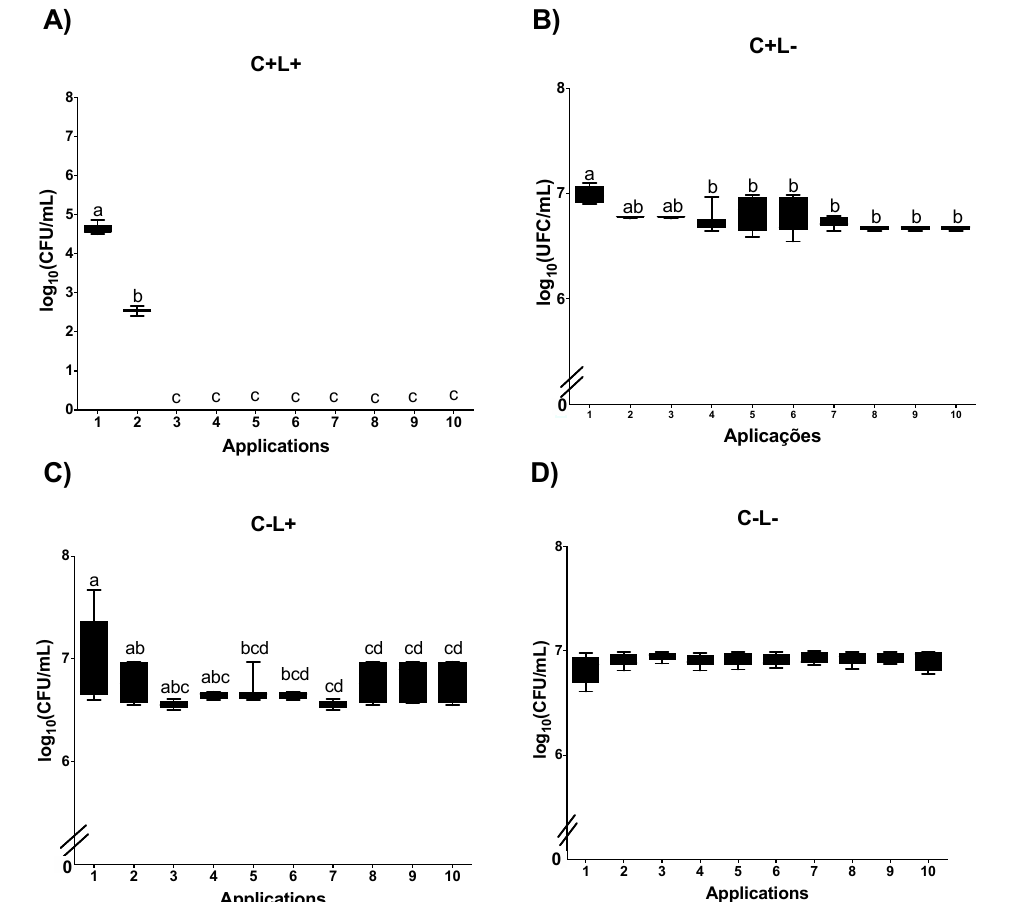
Figure 5. Log 10 values (CFU/mL) of planktonic cultures of C. albicans submitted to ( A ) CUR (C+L+), ( B ) CUR (C+L − ), ( C ) light (C − L+), and ( D ) experiment control (C − L − ) grown in fluconazole. Upper limit of the box: third quartile; lower limit of the box: first quartile; error bars: minimum and maximum values. Different letters (a; b; c; d) denote a statistical difference between columns (applications) according to Dunn’s post-test ( p < 0.05) ( n = 12). For the biofilm of C. albicans submitted to aPDT mediated by PDZ (P+L+) plated on SDA, a significant reduction was observed between Apl#1 and Apl#6 (3.5 log 10 CFU/mL) and between Apl#1 and Apl#10 (6.2 log 10 CFU/mL) (Figure 6A). In the P+L − group, no more than 1 log 10 CFU/mL of reduction in fungal viability was observed between Apl#1 and Apl#10 (Figure 6B). For the P − L+ group, a significant reduction was observed between Apl#1 and Apl#10 (0.86 log 10 CFU/mL of drop) (Figure 6C). In addition, no significant difference was observed in the control group (P − L − ) (Figure